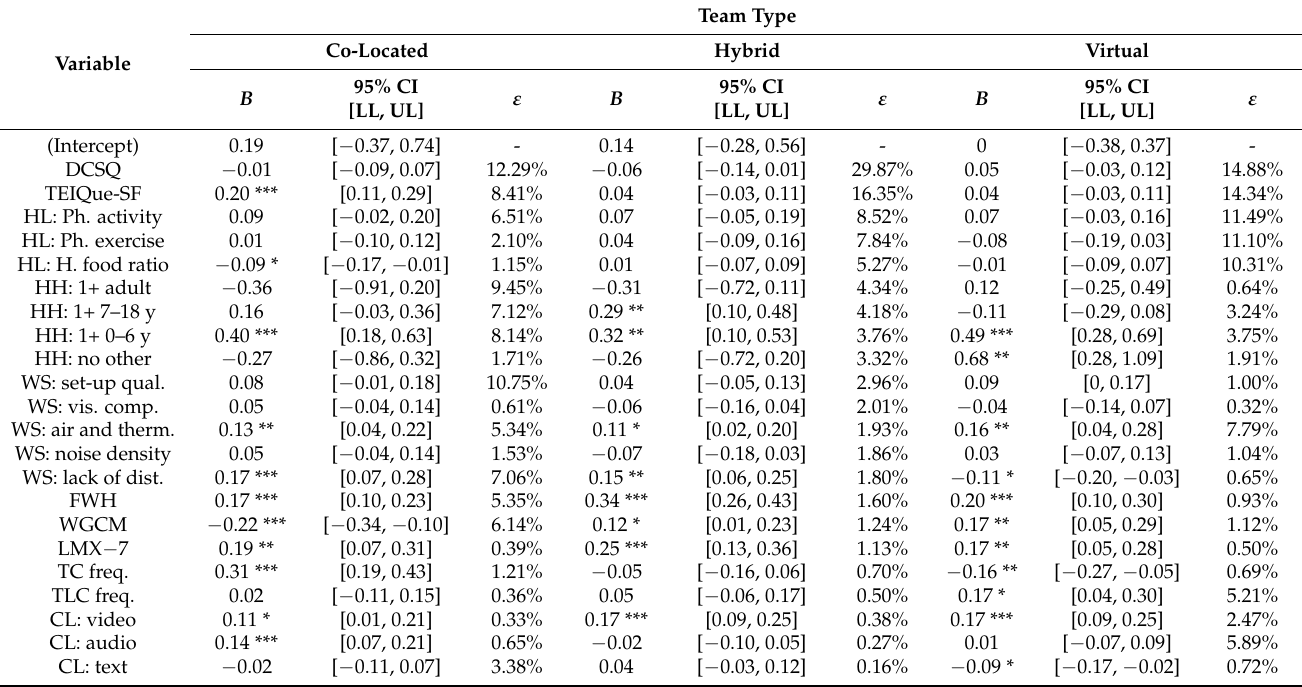
Table 3. Regression and relative weight